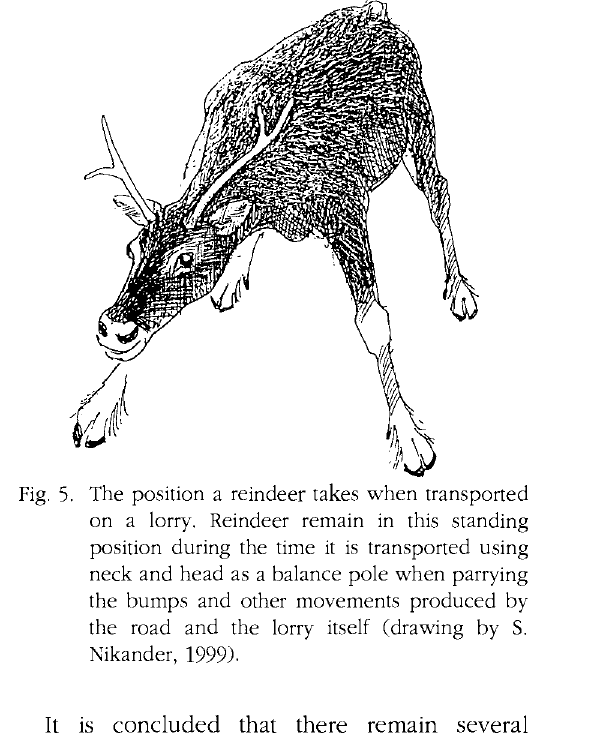
Fig. 5. The position a reindeer takes when transported on a lorry. Reindeer remain in this standing position during the time it is transported using neck and head as a balance pole when parrying the bumps and other movements produced by the road and the lorry itself (drawing by